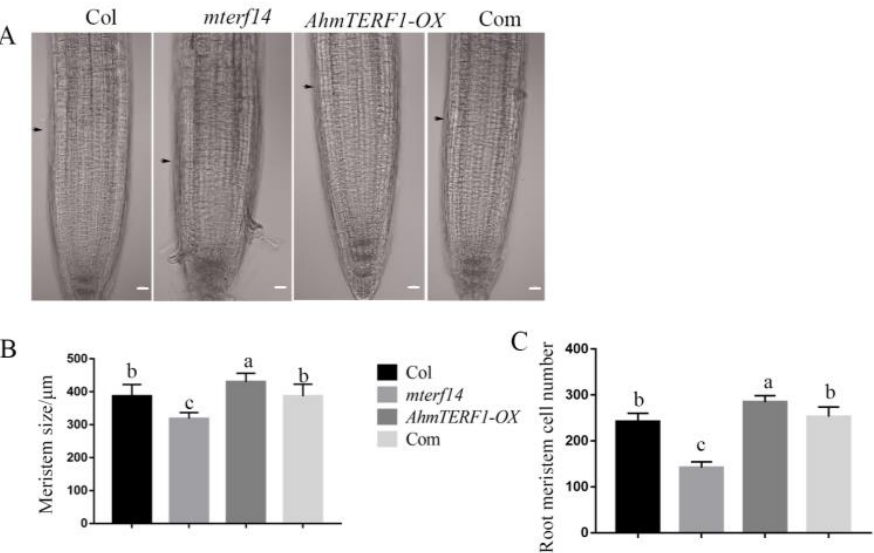
Figure 5. AhmTERF1 accelerates root meristem growth in Arabidopsis plants. ( A ): Images of root meristem in AhmTERF1-OX transgenic Arabidopsis . Scale bars: 20 µm. Arrows indicate the boundary between the root meristem and the elongation zone. ( B , C ): Meristem size and cell number of roots in A. Com indicates 35S:AhmTERF1/mterf14 Arabidopsis plants. Lower case letters (a, b, c) indicate significantly different groups ( p < 0.05).